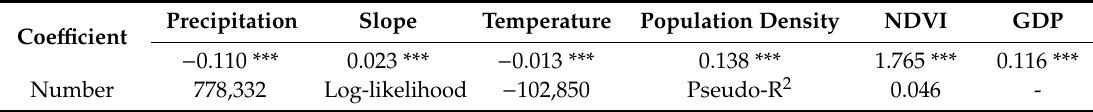
Table 1. Results of the probit model at the national level from 2000–2015.